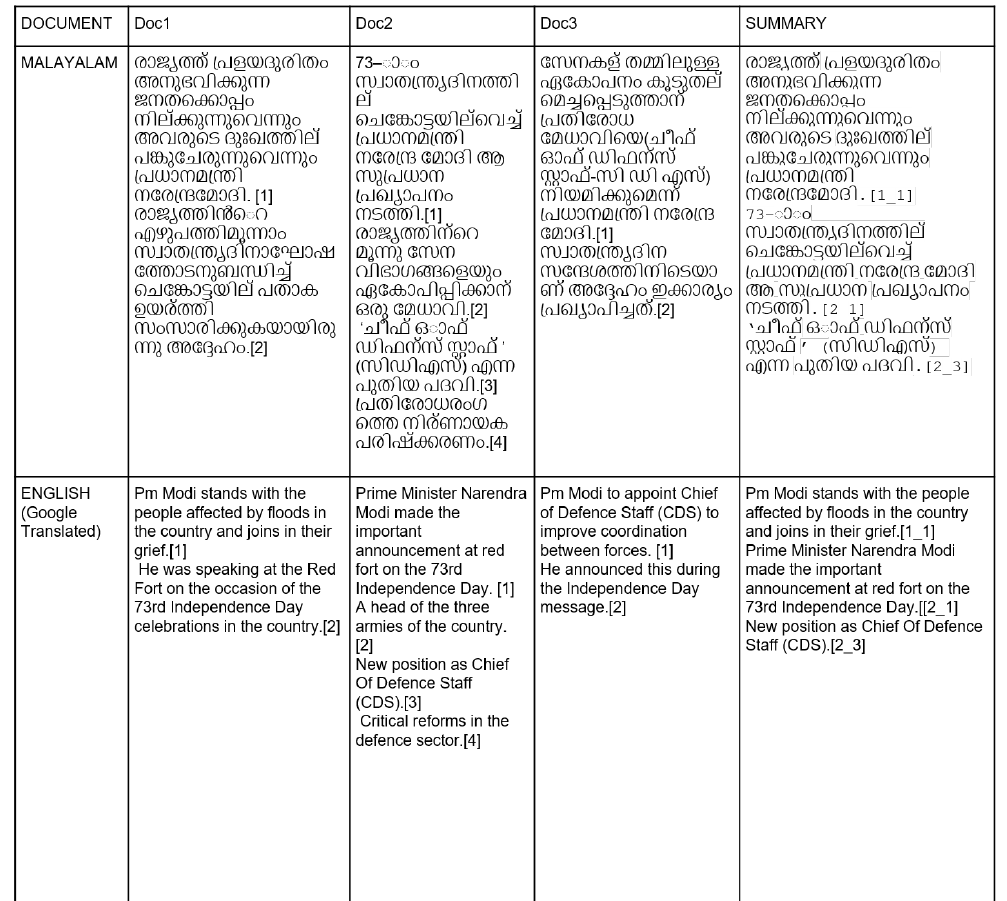
Figure 3. Sample output of the multi-document summarization (MDS) system on taking Doc1, Doc2 and Doc3 of Figure 4 as inputs and using modified TextRank to get individual summary as well as the candidate summary. 1_2 refers to sentence 2 in Document 1.